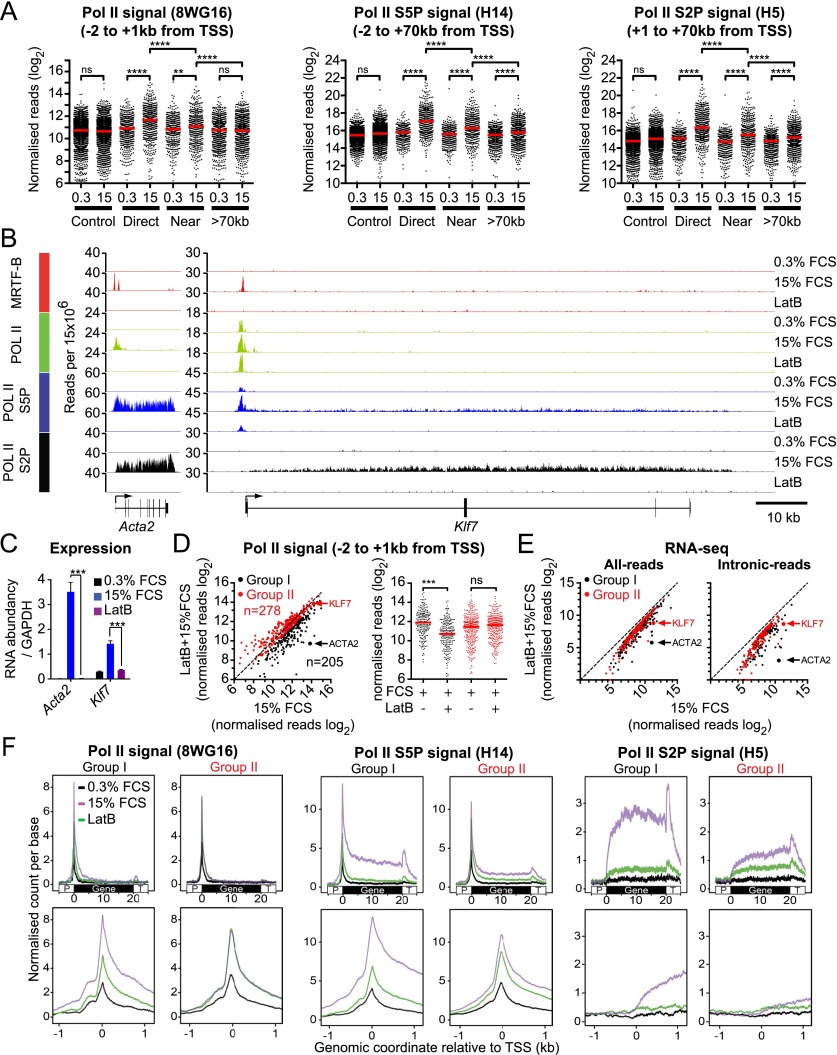
MRTF acts at Pol II recruitment and post-recruitment steps. (A) Serum-induced genes exhibit increased Pol II loading. RNA Pol II ChIP-seq analysis with antibodies as follows: 8WG16 (Pol II CTD un-P), total reads from −2 kb to +1 kb from TSS; H14 (Pol II CTD S5P), total reads from −2 kb to the gene 3′ end or +70 kb, the limit of Pol II progress after 30 min of stimulation; and H5 (Pol II CTD S2P), total reads from +1 to the gene 3′ end or +70 kb. Statistical significance, Mann-Whitney test, (**) P < 0.01; (****) P < 0.0001. (B) Representative MRTF-B and Pol II ChIP-seq tracks on Acta2 and Klf7. (C) LatB inhibits serum induction of Klf7 and Acta2, assessed by qRT–PCR. SEM of three independent experiments. (D) MRTF is required for Pol II recruitment on a subset of target genes. Four-hundred-eighty-three genes were analyzed whose serum-induced activation was LatB-sensitive in the absence of U0126. (Left) Scatter plot summary of the Pol II ChIP-seq signal from −2 to +1 kb around the TSS. Genes exhibiting >30% reduction (group I) are shown in black, and those exhibiting <30% reduction (group II) are in red. (Right) Summary of LatB’s effect on the two groups. Statistical significance, Mann-Whitney test, (***) P < 0.001. (E) LatB inhibits group I and group II gene RNA synthesis to a similar extent in RNA-seq. (F) Metaprofiles of Pol II ChIP-seq for group I and group II genes. (Top) 8WG16, H14, and H5 normalized ChIP-seq read counts are shown across gene loci, standardized to 20 kb, and flanking 5 kb. (Bottom) Read counts from −1 kb to +1 kb from the TSS.